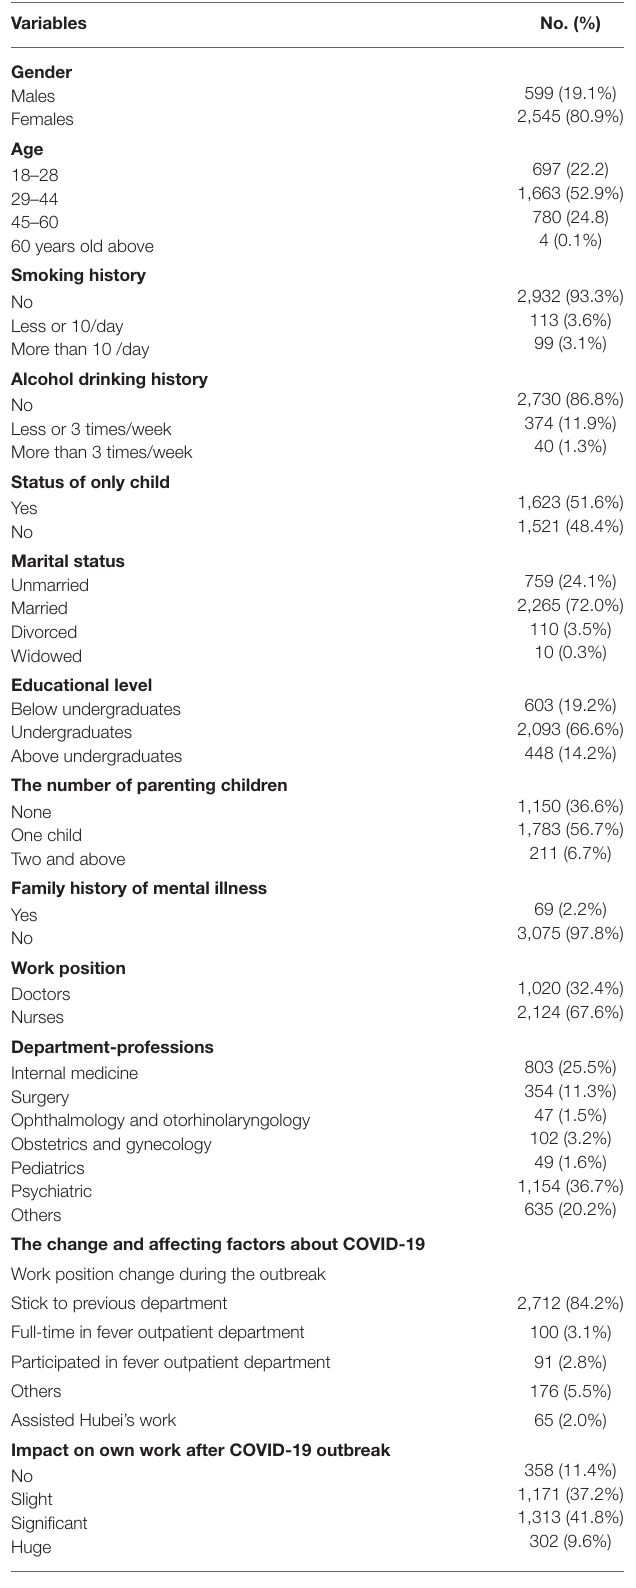
TABLE 1 | Sociodemographic characteristics of participants and outbreak-related issues ( N = 3,144).